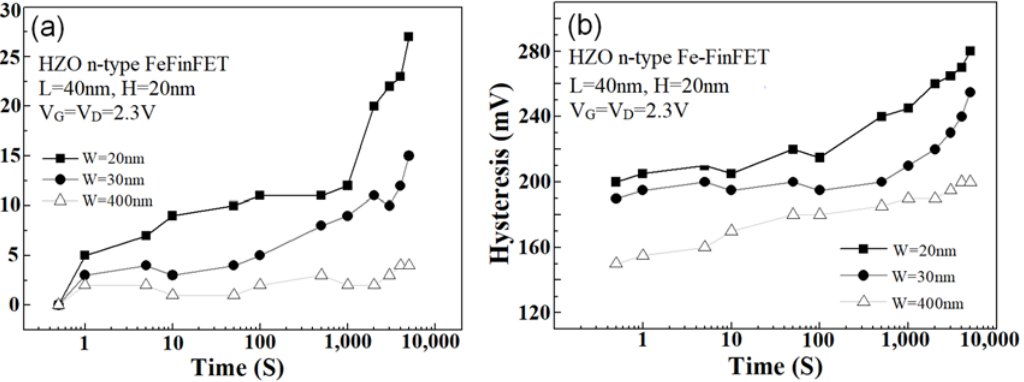
Figure 4. Hot-carrier-induced ( a ) subthreshold swing and ( b ) hysteresis degradations for various Figure 4. Hot - carrier - induced ( a ) subthreshold swing and ( b ) hysteresis degradations for various fin-widths of n-type fin ‐ widths of n - type Fe - FinFET.